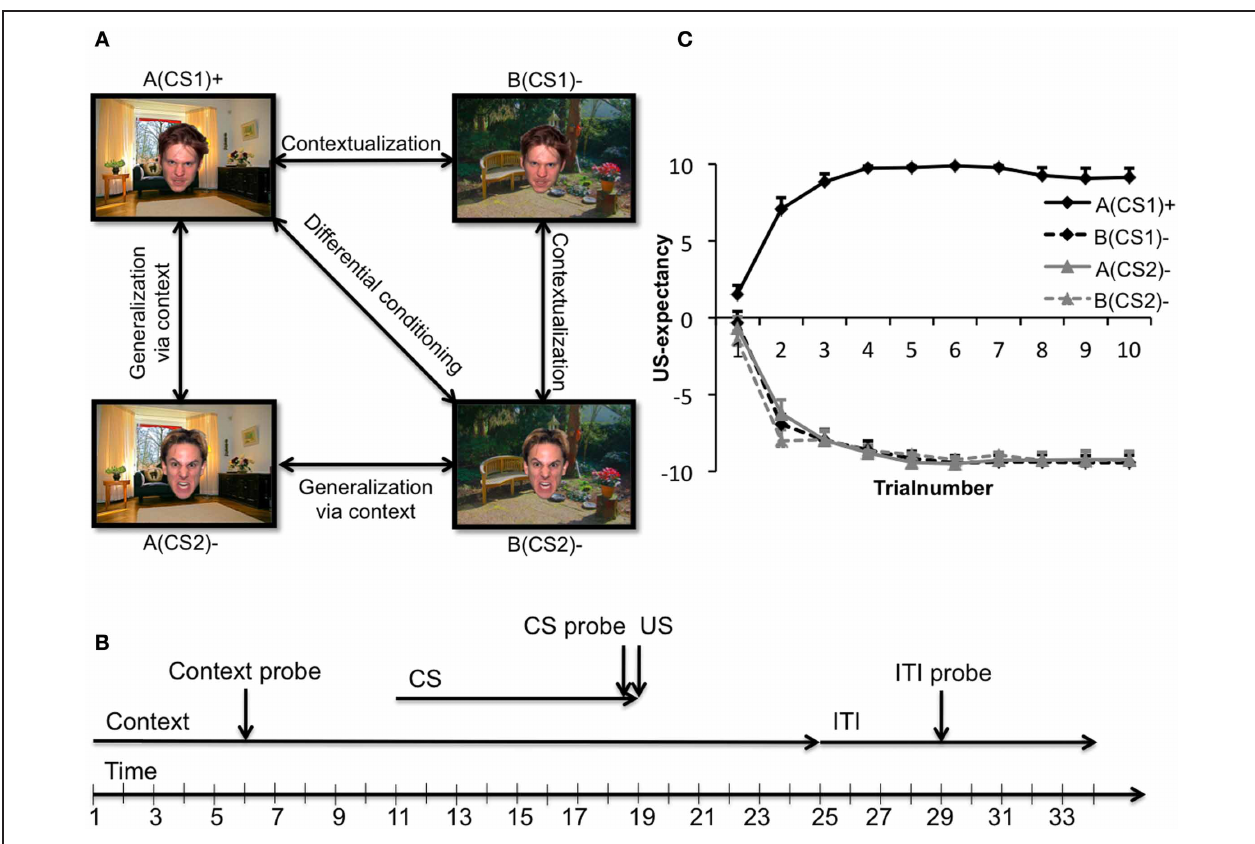
FIGURE 1 | (A) Experimental conditioned stimuli and relevant comparisons. An image of a living room and an image of a garden constituted the safe (context B) and threat (context A) contexts, while two angry faces constituted the CS + (CS1) and CS − (CS2). Several comparisons of interest concerning fear contextualization and fear generalization exist. A(CS1) + > B(CS2) − denotes differential conditioning; A(CS1) + > B(CS1) − denotes proper fear contextualization; B(CS1) > B(CS2) denotes impaired contextualization; A(CS1) + > A(CS2) − denotes less fear generalization via the context; A(CS2) − > B(CS2) − denotes fear generalization via the context. (B) Timeline of an exemplary trial. Each trial started with the